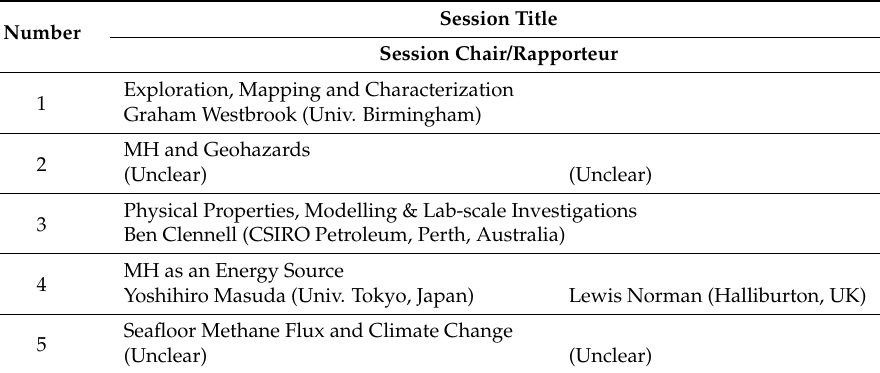
Table 6. Breakout sessions (title and